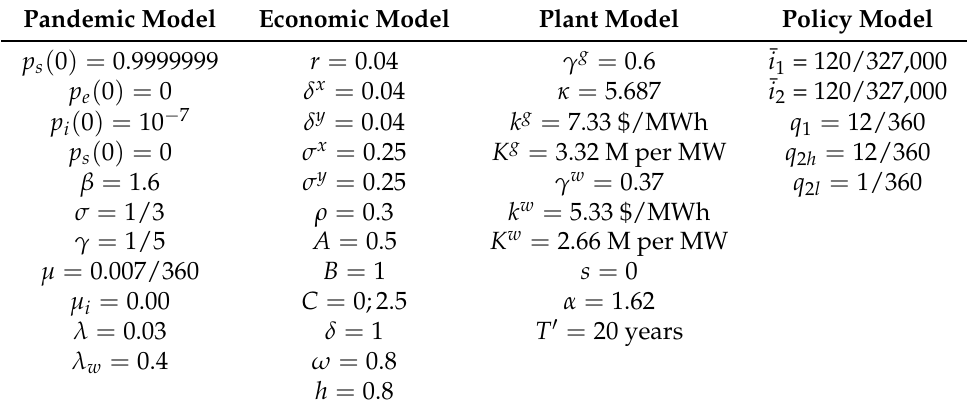
Figure 1. Upper panel displays the evolution of effective workforce p e w (dashed) and pandemic factor Z (solid) during the outbreak. Lower panel plots the investment boundary for the wind plant as a function of time. Solid line corresponds to the pandemic case, dashed line to the no-pandemic case. Parameter values are given in Table 1; the investment horizon is T = 1 year. Table 1. Parameter